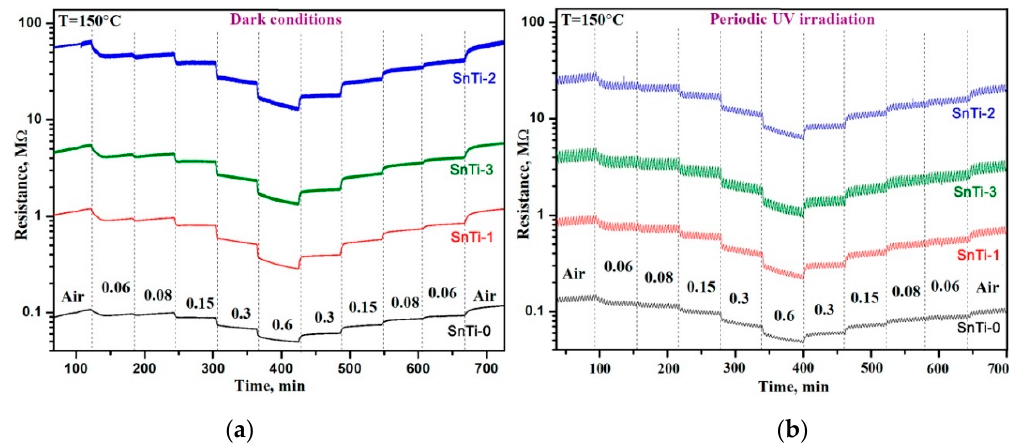
Figure 12. Resistance of the TiO 2 @SnO 2 nanocomposites at T = 150 °C under stepwise change of the HCHO concentration ( a ) in dark conditions; ( b ) under periodic UV ( λ max = 365 nm) illumination. The numbers in the figure correspond to HCHO concentration (ppm).